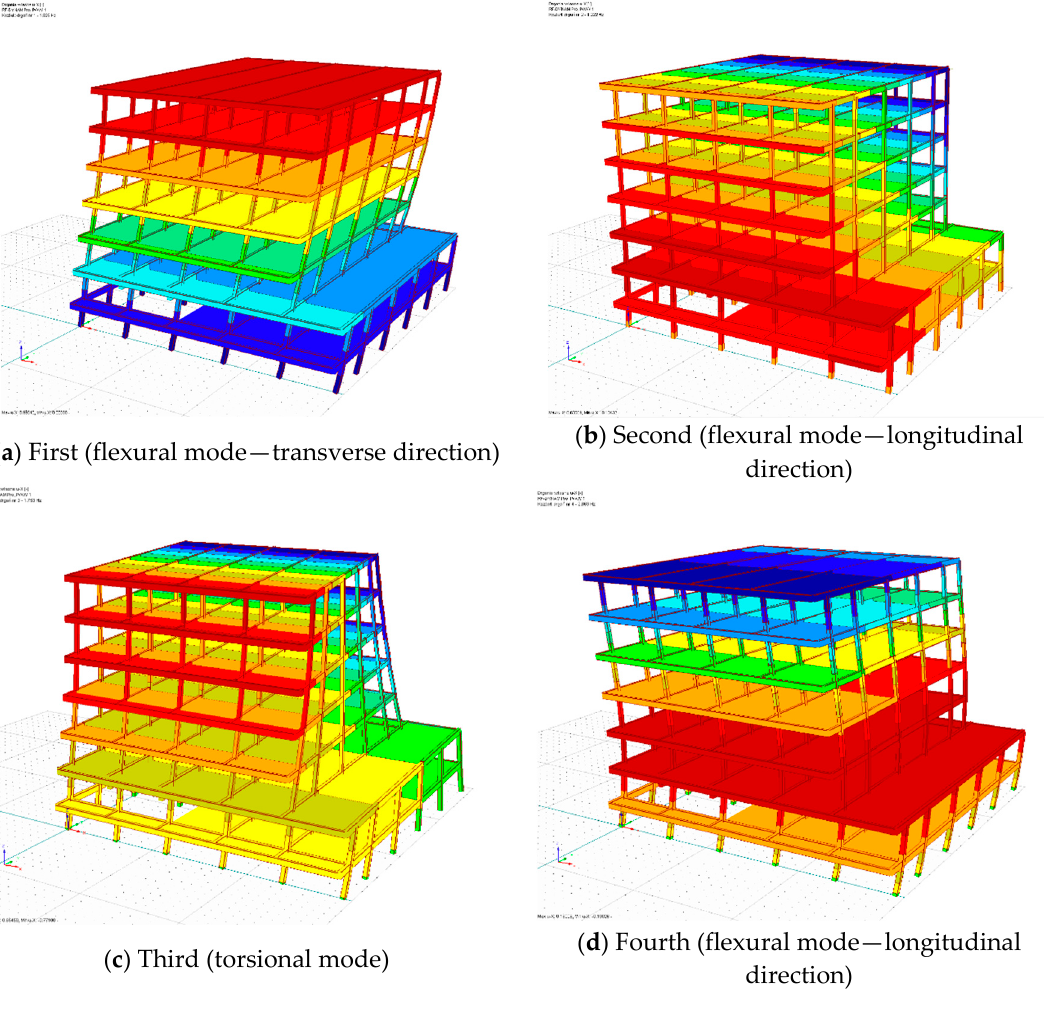
Figure 6. Modes of free vibrations for building A.